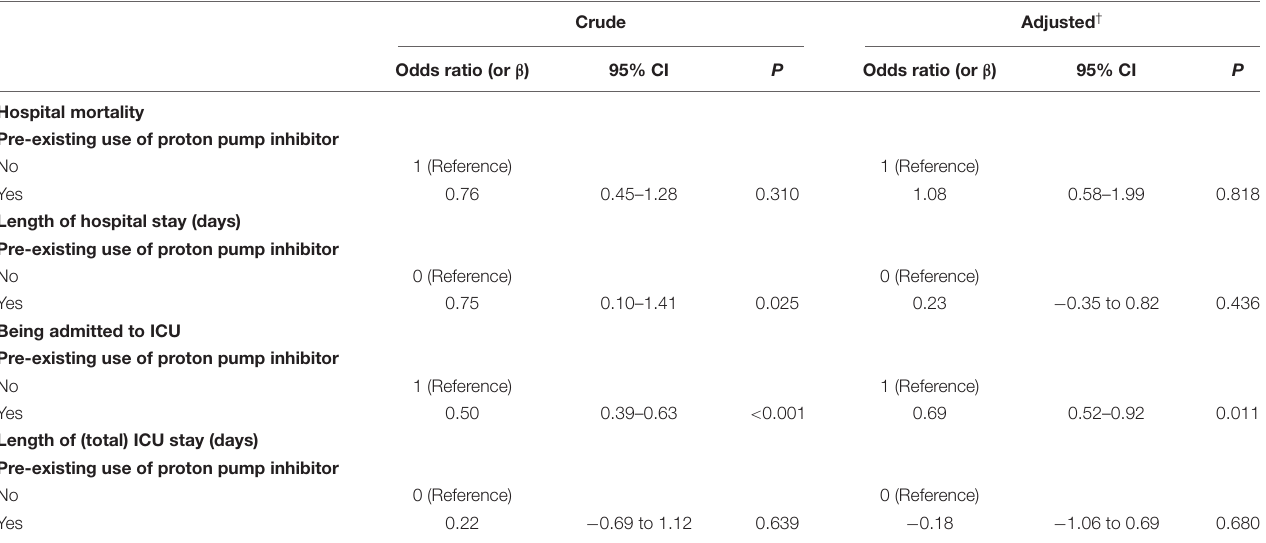
TABLE 3 | Associations of pre-existing use of proton pump inhibitor and prognosis of the study